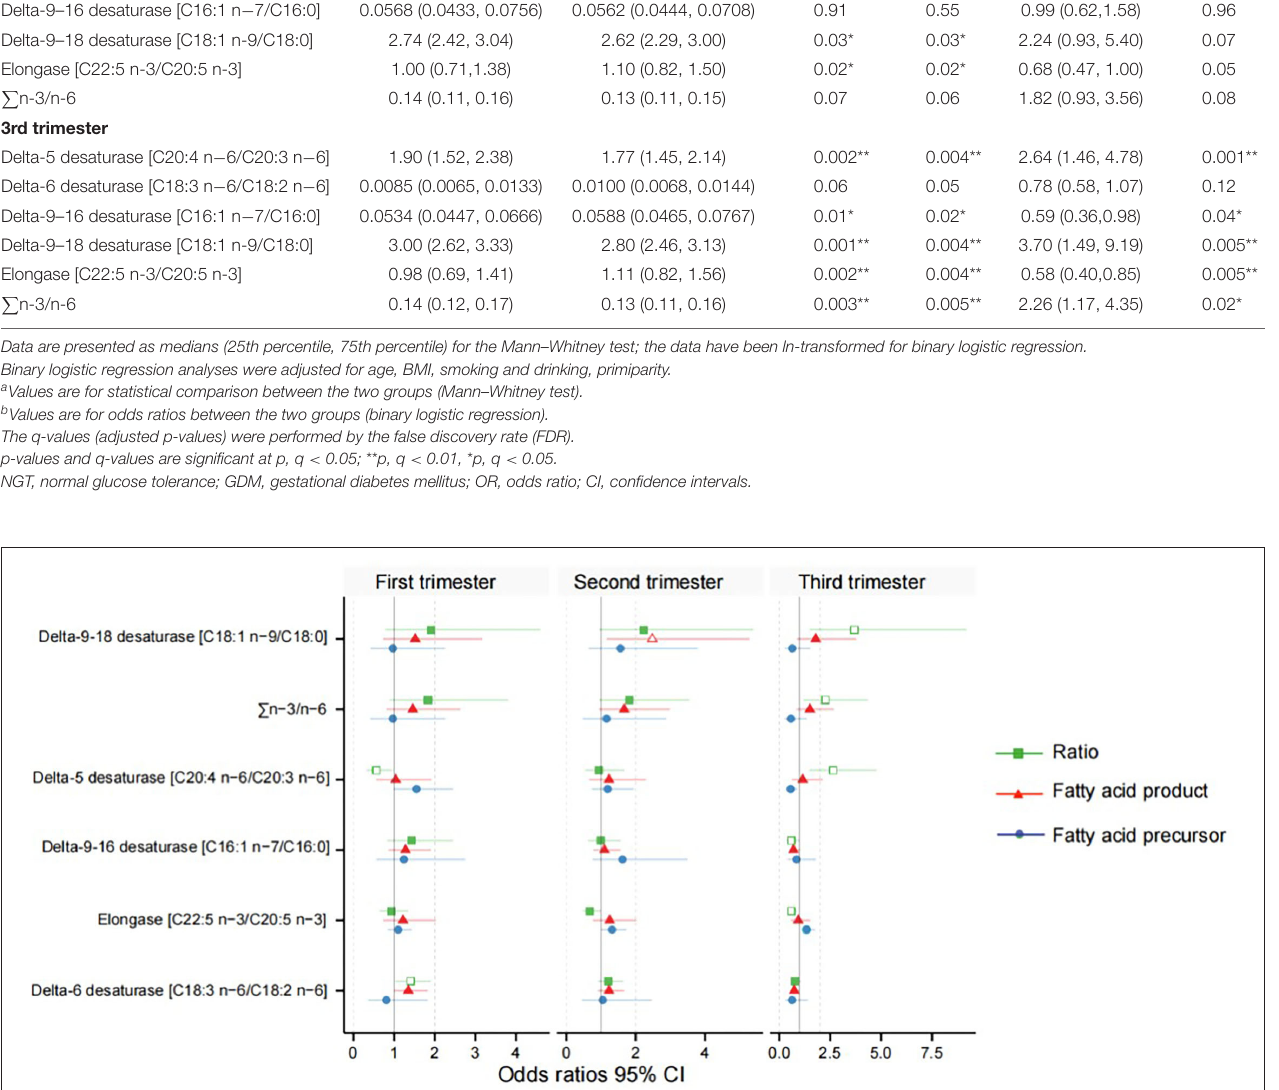
Frontiers in Nutrition |